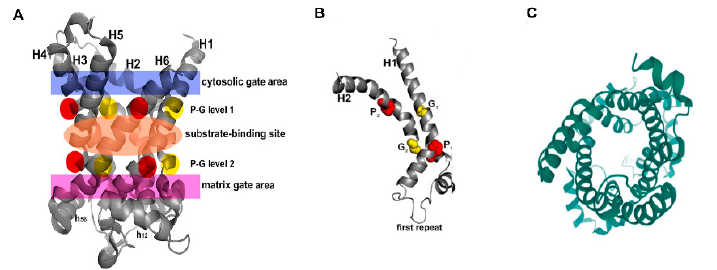
Figure 2. Molecular models of uncoupling proteins. ( A ) Crystal structure of the adenine nucleotide transporter from which most of the structural models of UCPs are derived. The 3D crystal structure of the carboxyatractyloside-ADP/ATP carrier complex (devoid of the inhibitor) is shown with the following regions in color: cytosolic gate (blue); substrate-binding site (orange); and matrix gate (purple). In P1–G1 and P2–G2, prolines are shown in red and glycines in yellow. ( B ) The crystal structure of the first repeat of UCP2. Key prolines are marked in red and glycines in yellow. ( C ) When rotated 90 ◦ and viewed at end on, UCP2 and other members of the SLC25 transporter family have a clear central pore. Adapted from Reference